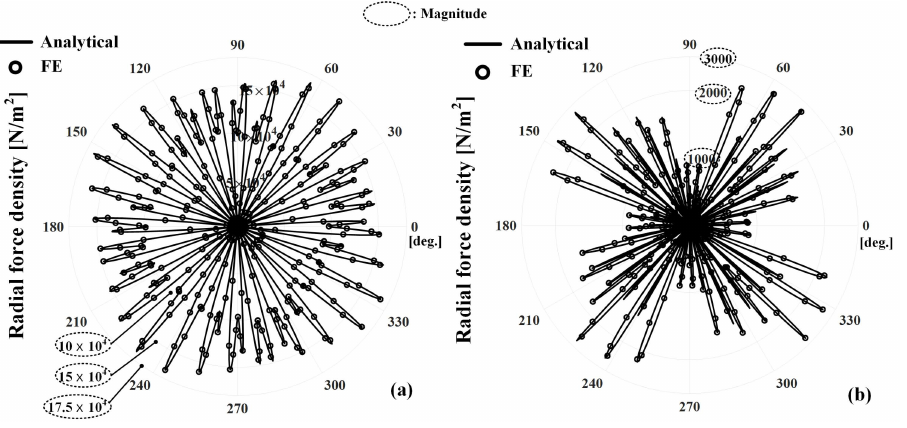
Figure 7. MPFs due to ( a ) PMs and ( b ) armature